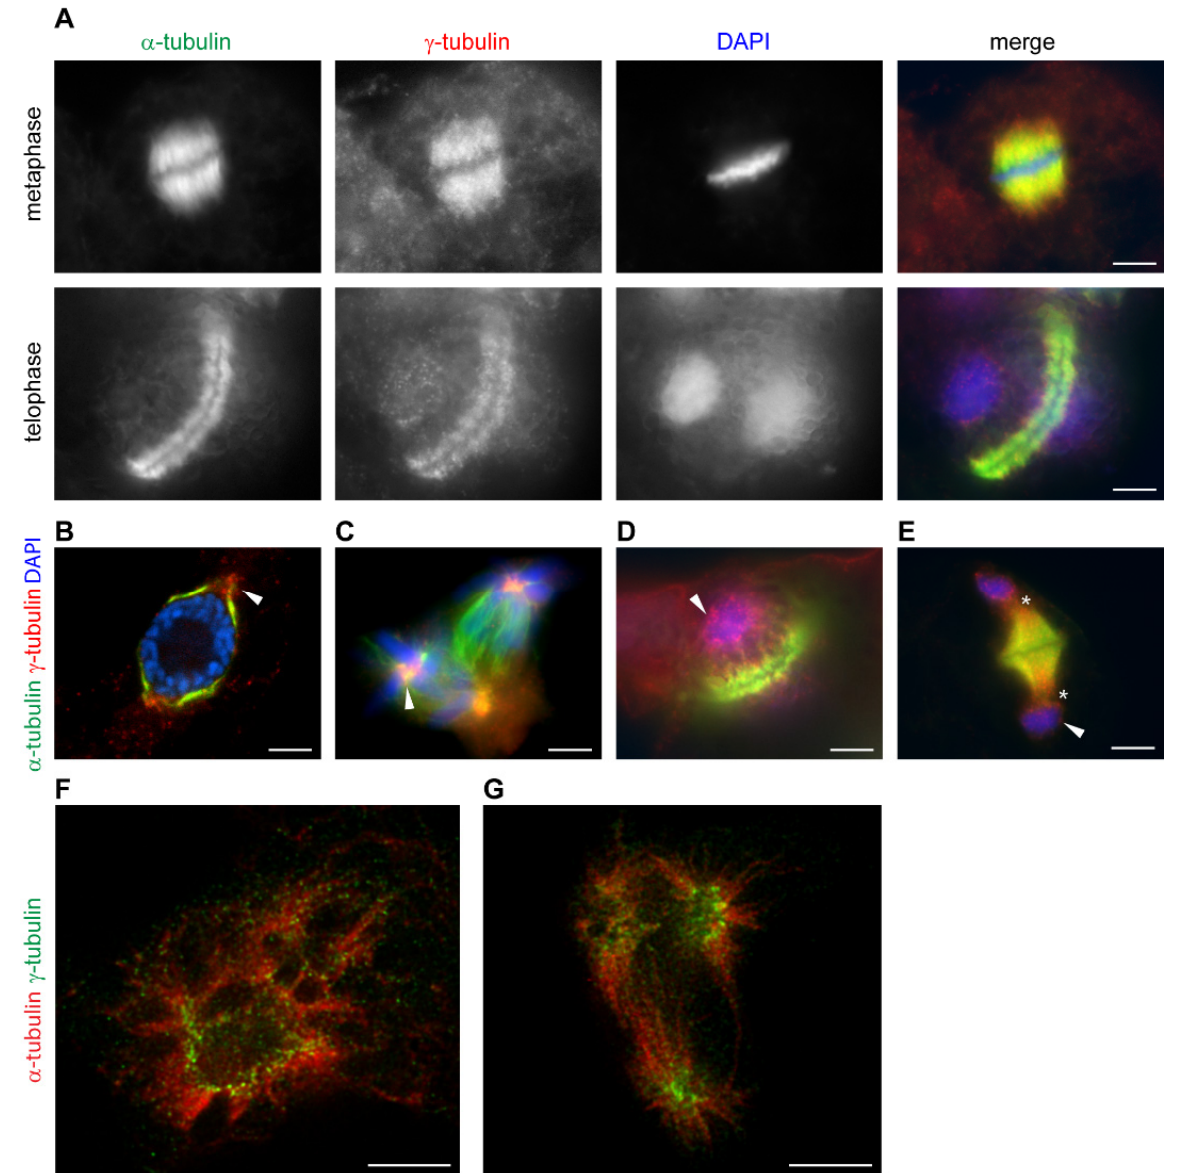
Figure 2. γ -Tubulin localizes with mitotic microtubular arrays and a nuclear envelope in a cell cycle-dependent manner in acentrosomal plant cells. ( A – G ): Immunofluorescence labelling of γ -tubulin and α -tubulin in Arabidopsis cells—( A ) γ -Tubulin localizes with microtubules of mitotic spindle and phragmoplast. ( B – E ): γ -Tubulin localization in cells treated with roscovitine—( B ) γ -Tubulin forms condensated protrusions at polar regions in the vicinity of nuclei in cells arrested at G2/M (arrowhead); ( C ) γ -Tubulin foci in centers of chromosomal asters (arrowhead) of a multipolar spindle of Vicia faba ; ( D , E ) γ -Tubulin is localized with minus ends of microtubules of aberrant phragmoplasts, often extending into the cytoplasm (asterisks) and patches of γ -tubulin are observed with newly formed nuclei (arrowhead); ( F , G ): STED (stimulated emission depletion) microscopy images of roscovitine- and taxol-treated cells of Arabidopsis . (time-gated continuous wave STED, 660 nm depletion laser, deconvolution by Huygens); ( F ) γ -Tubulin fibrillar arrays accumulate with nuclei in cells arrested at G2/M; ( G ) γ -Tubulin fibrillar arrays are enriched in the centers of chromosomal asters of multipolar mitosis. ( A – E ): Olympus Cell-R microscopy—( F , G ): super-resolution Leica TCS STED 3X microscope. Scale bars: 5 µ m ( A – G